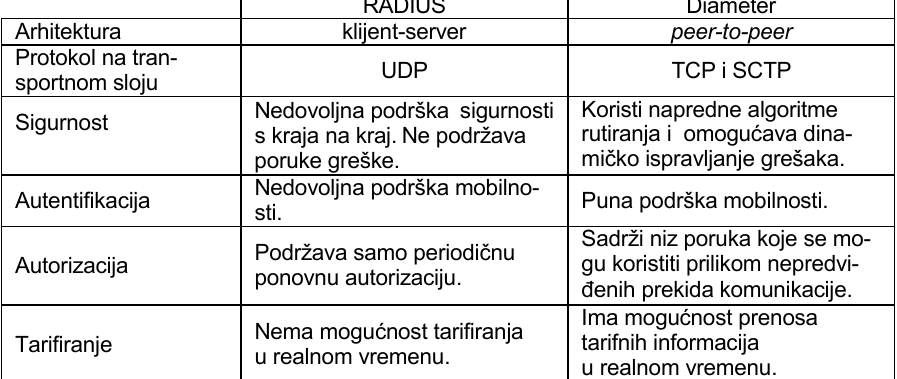
Table 1 – Comparison of the RADIUS and Diameter